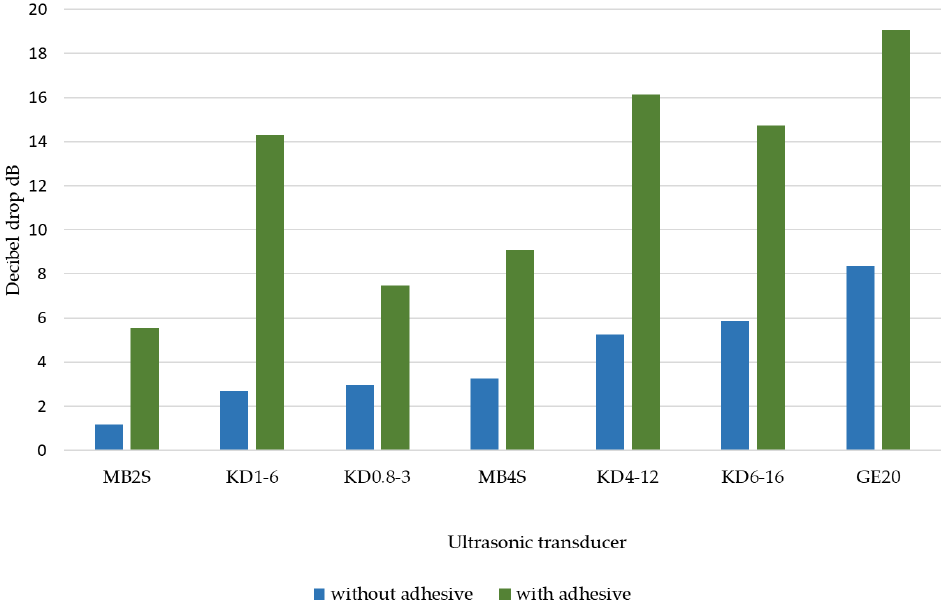
Figure 7. Decibel drop for samples with and without adhesive of Ti6Al4V material.